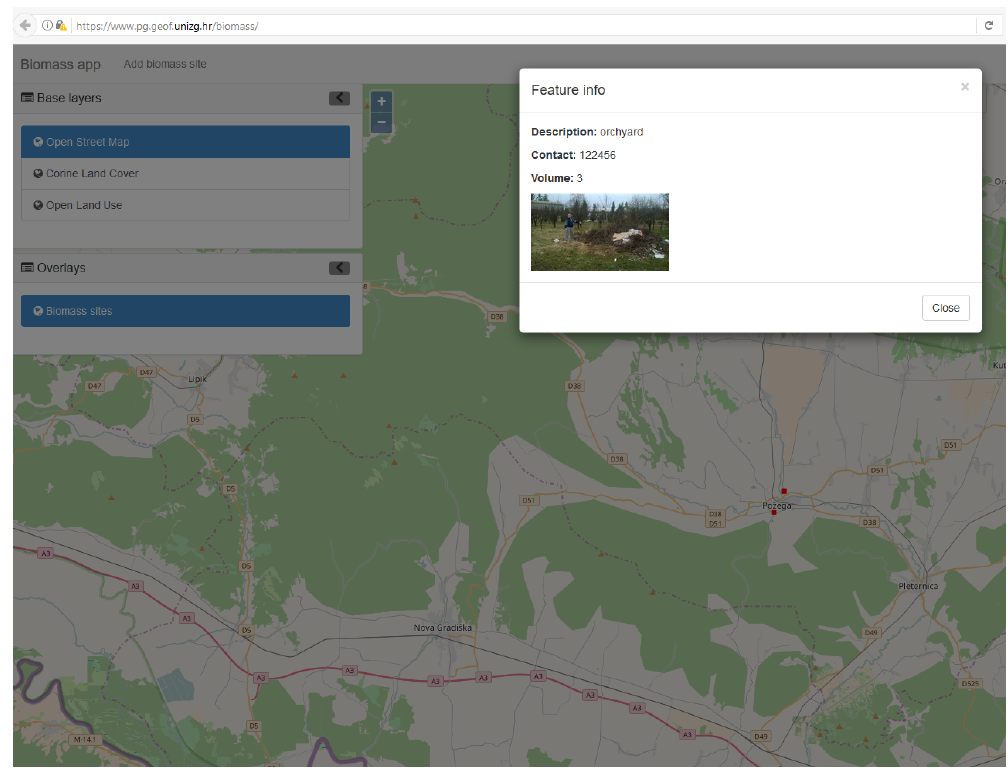
Figure 10. Web interface of